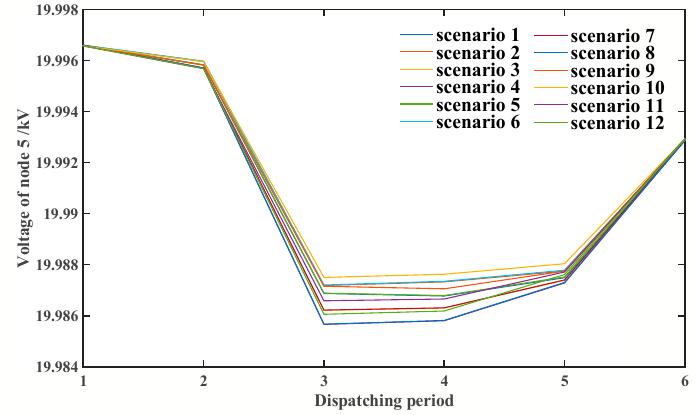
Figure 9. Voltage of node 5 under all scenarios.